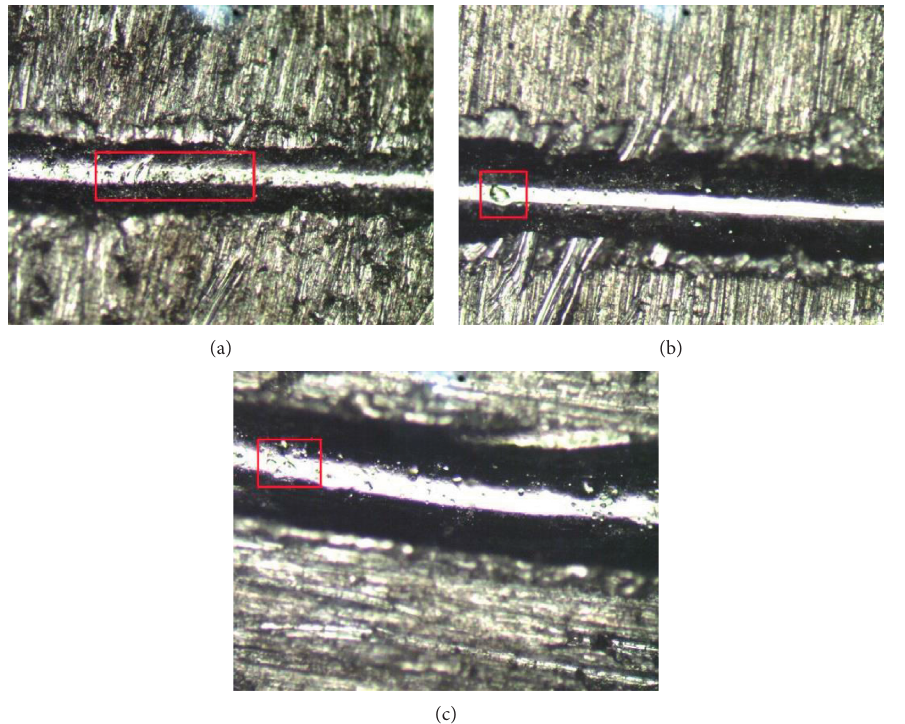
Figure 8: Scratch charts of three coatings: (a) 40% Al-60% Zn, (b) 30% Al-70% Zn, and (c) 20% Al-80%